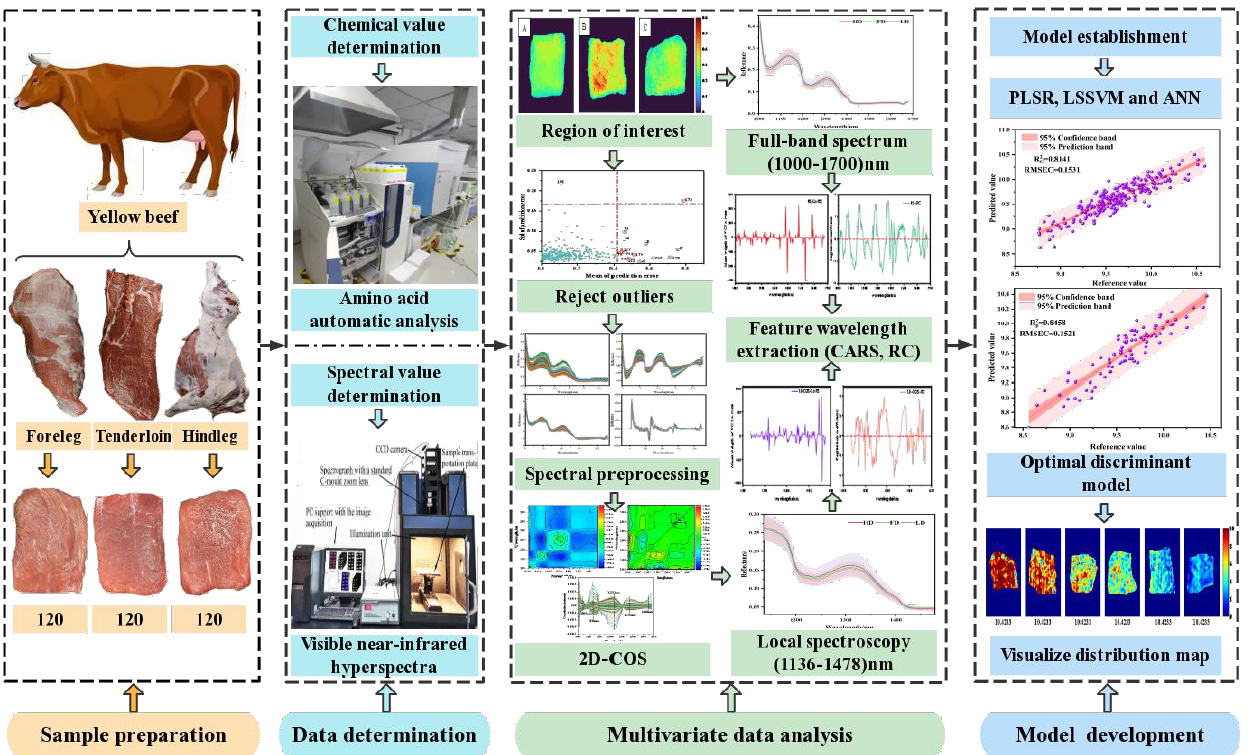
Figure 1. Technical roadmap of NIR–HSI detection of Ala content.